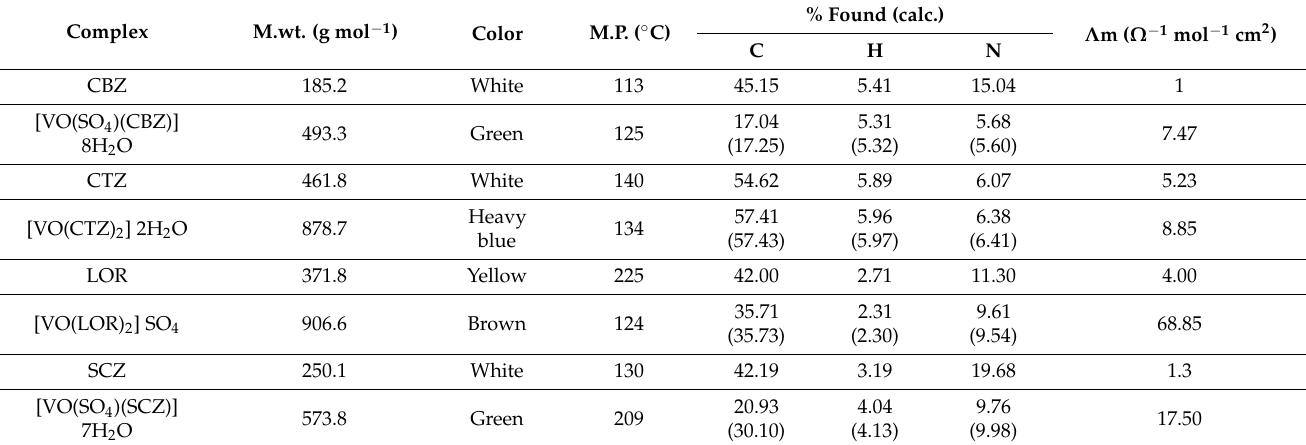
Table 1. The effective analytical and physical data of ligands and their oxidovanadium (IV) complexes.